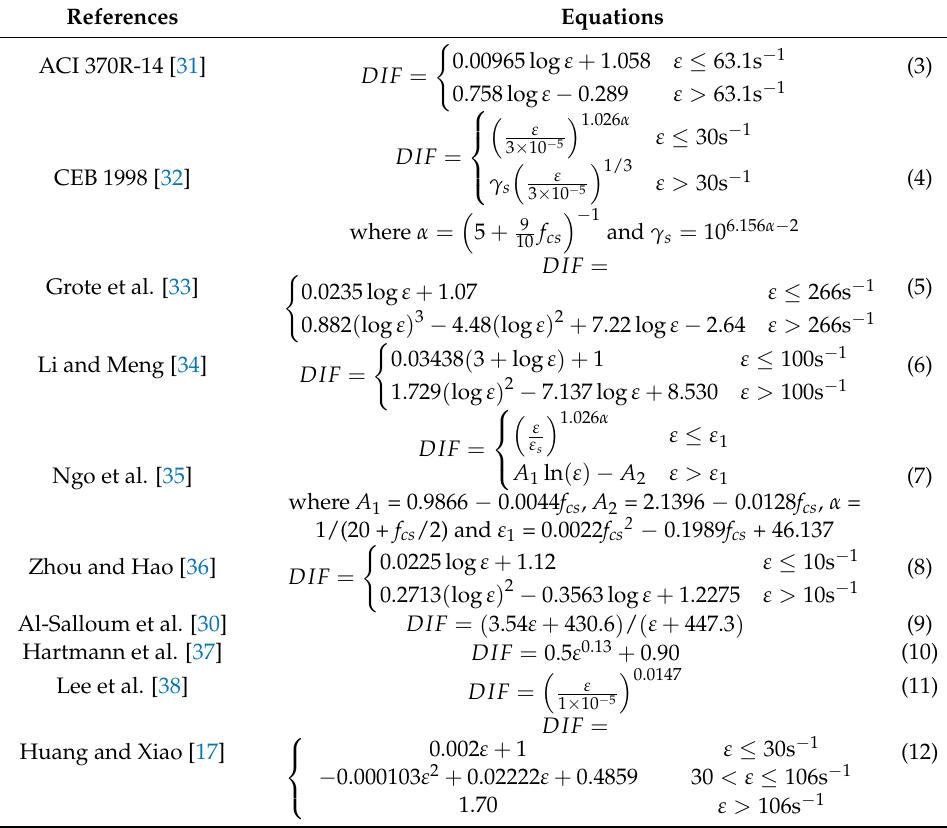
(i.e., Equations (3), (5)–(9) and (11)) and some equations agree with the DIF profile in the 50 s − 1 strain rate (i.e., Equations (7), (8) and (12)) or 100 s − 1 strain rate (i.e., (12)), while none of the equations can characterize these three strain rates. Table 3. Equations in the